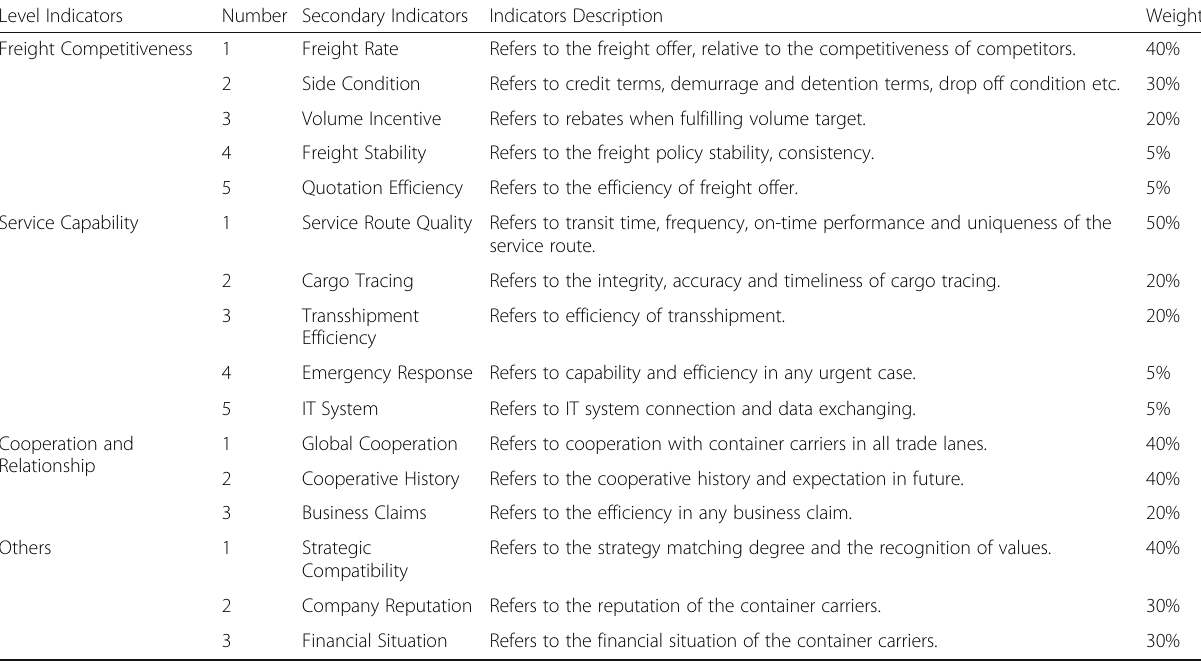
Table 1 Main indicators of port selection by customers. (Source: Authors) Level